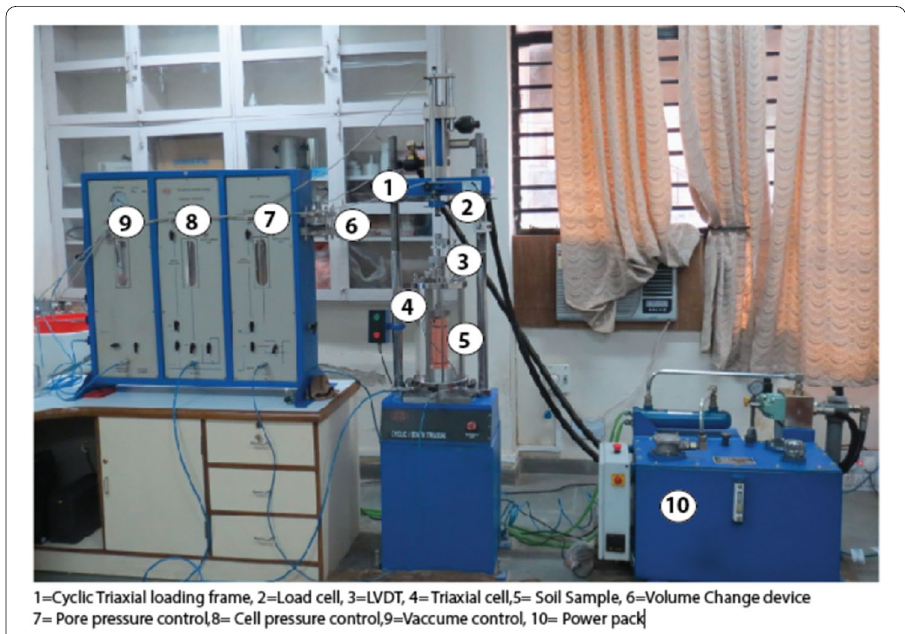
Fig. 4 Pictorial view of the testing apparatus used for the present study. Different number indicates the different parts of the Cyclic triaxial machine